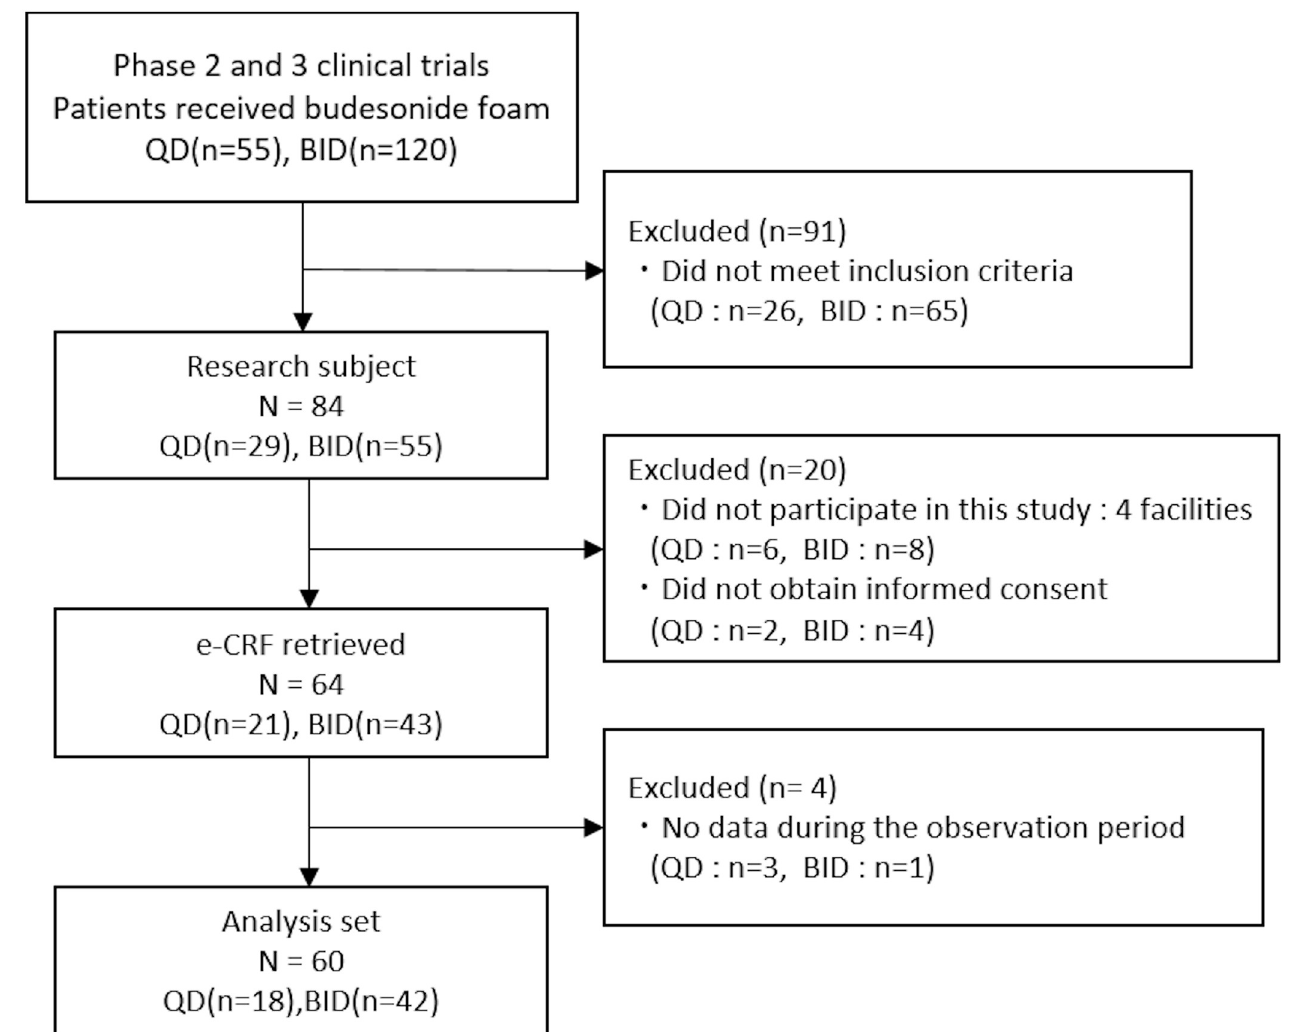
Fig 2. Patient disposition. eCRF, electronic case report form; BID, twice daily administration; QD, once daily administration.